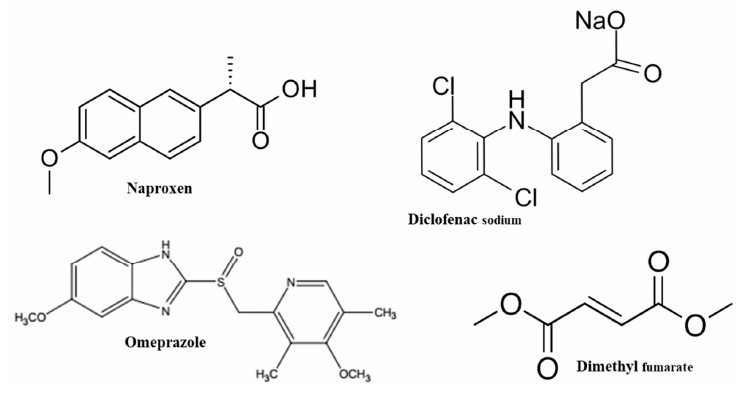
Figure 1. 2D structures of APIs.